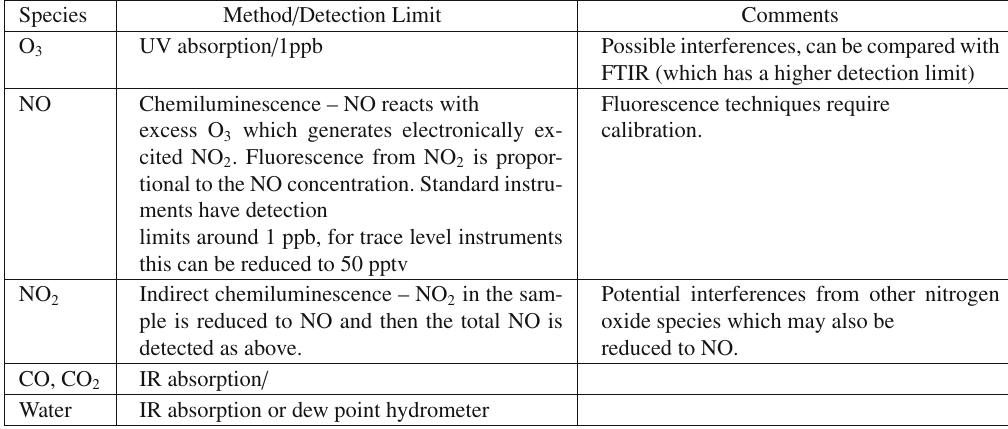
Table 2. Review of selected commercial